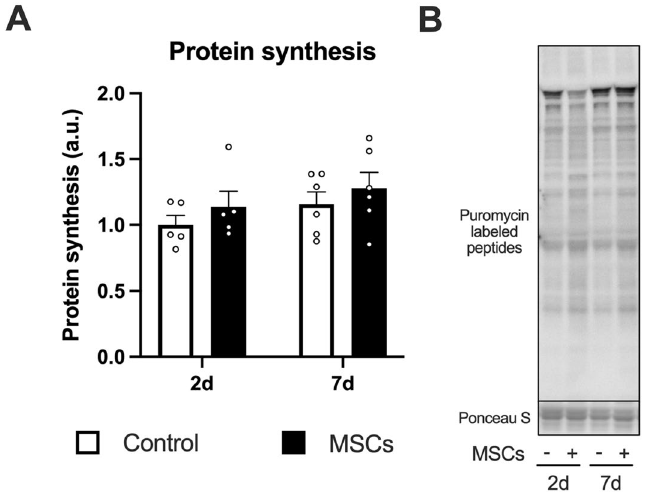
Figure 4. Muscle protein synthesis after intramuscular injection of MSCs. Data are expressed relative to the control leg at 2 days post intramuscular injection of MSCs as the mean ± SE. A significant main effect of MSC was observed (P <